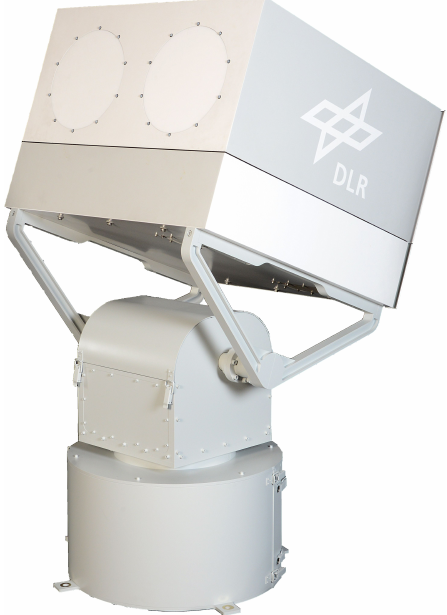
Figure 1. One of DLR’s remote controlled C-band Kalibri transponders on its two axis positioner. The positioner allows for precise alignment of the transponder in both azimuth and elevation.